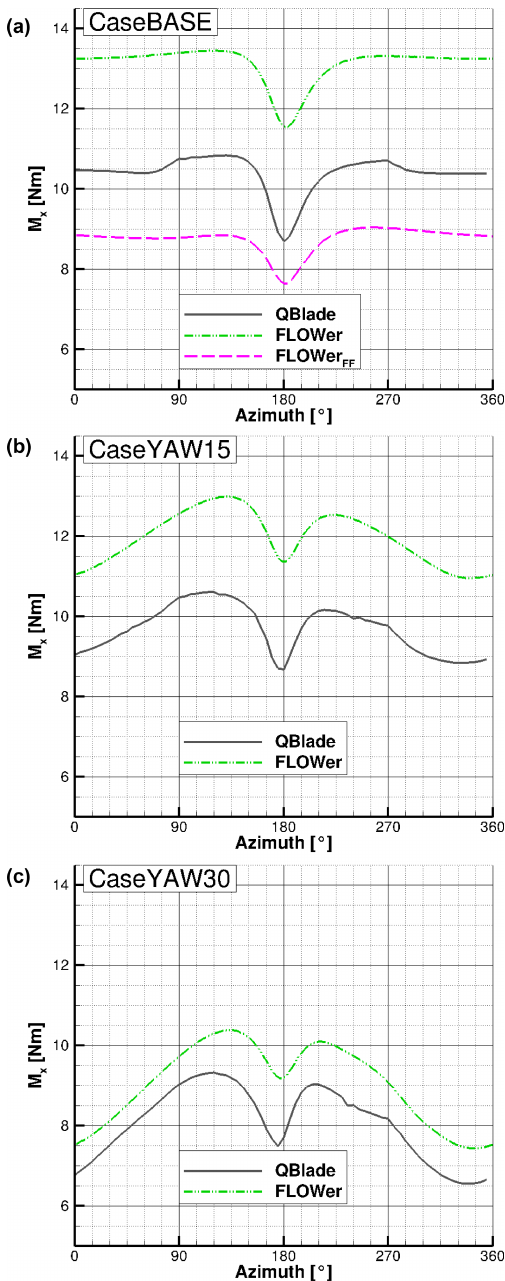
Figure 20. Edgewise bending moment ( M x ) over the azimuth for CaseBASE (a) , CaseYAW15 (b) and CaseYAW30 (c) , for QBlade and